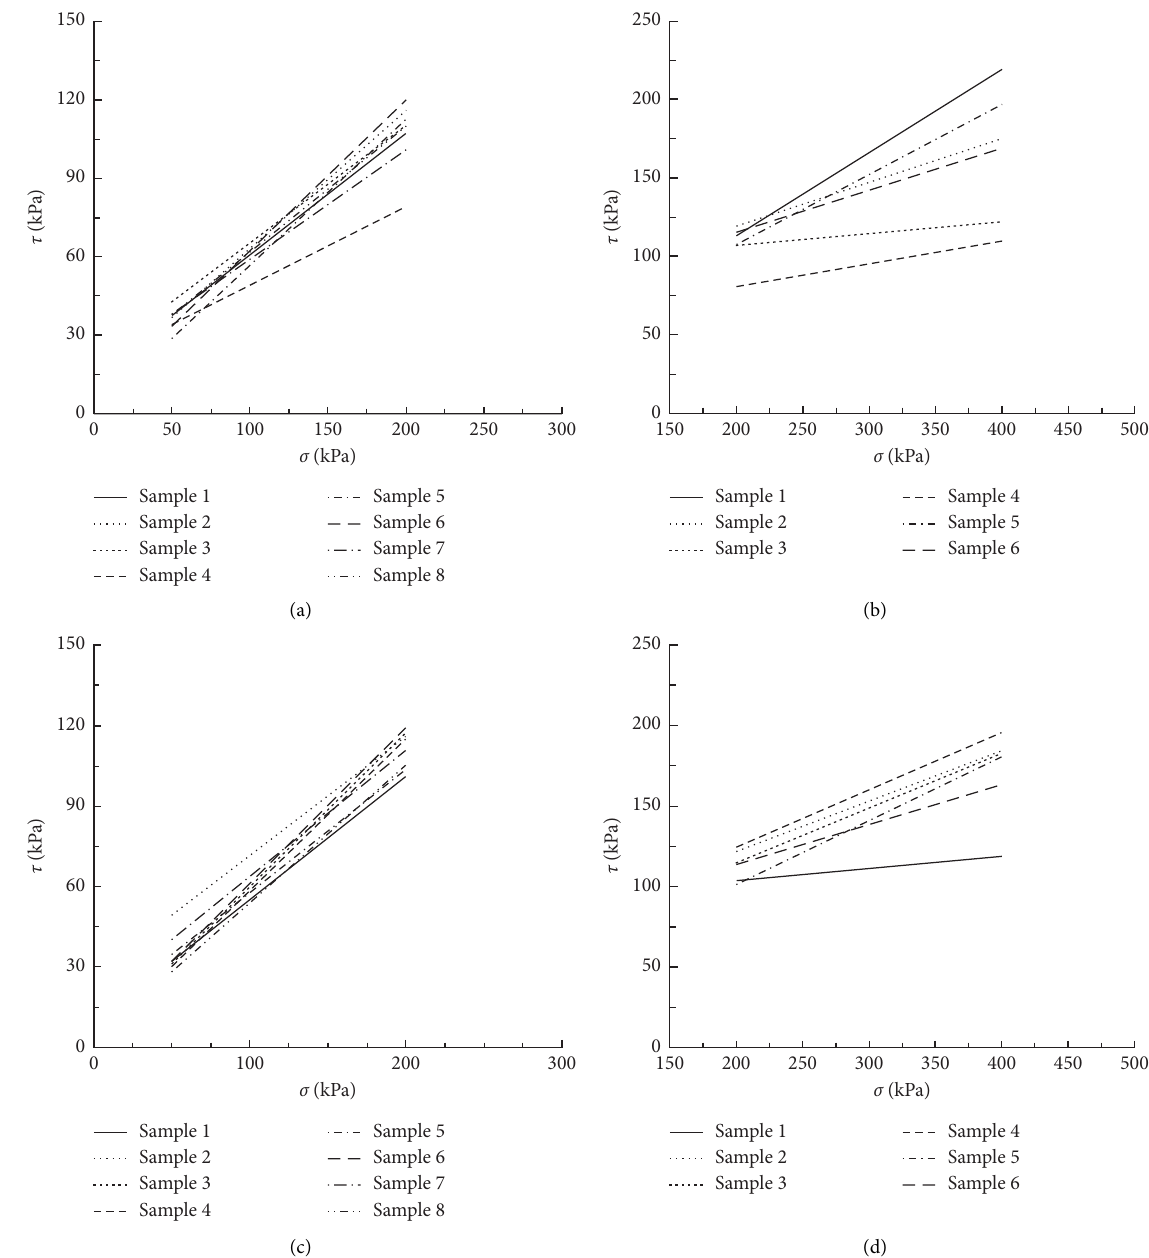
Figure 3: Shear strength envelopes of different samples under different vertical stress. (a) Wet method samples under 0–200 kPa of vertical stress; (b) wet method samples under 200–400kPa of vertical stress; (c) dry method samples under 0–200kPa of vertical stress; (d) dry method samples under 200–400kPa of vertical